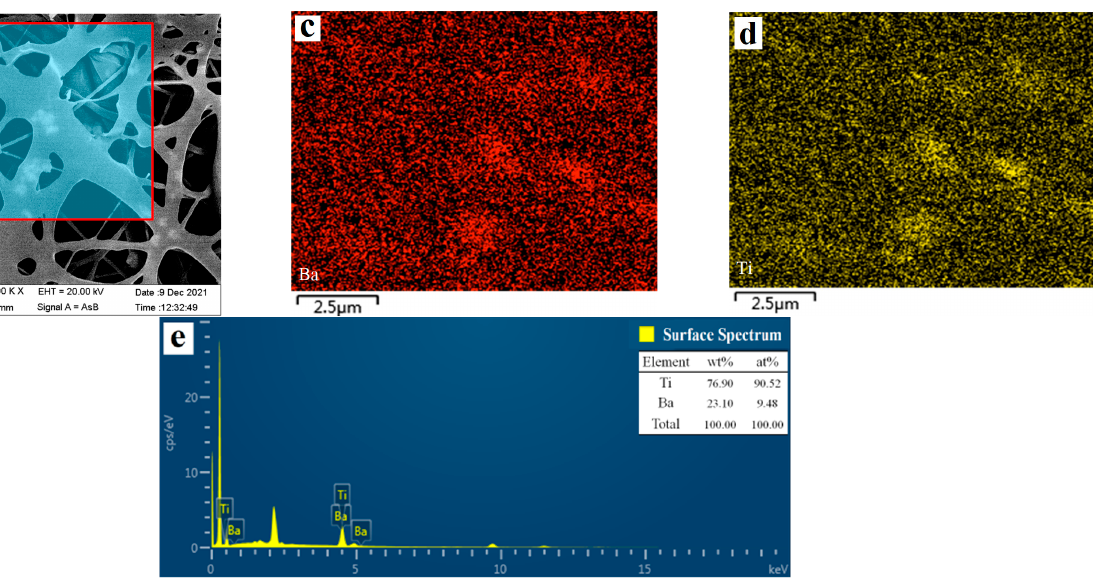
Figure 5. SEM & EDS analysis of polyurethane composite fiber membrane. Reprinted/adapted with permission from Ref. [16]. 2022, Membranes. ( a ) Electron microscope picture, ( b ) Energy spectrum analysis of selected areas in ( a ), ( c ) Distribution of Ba element, ( d ) Distribution of Ti element, ( e ) Content ratio of Ba element and Ti element.